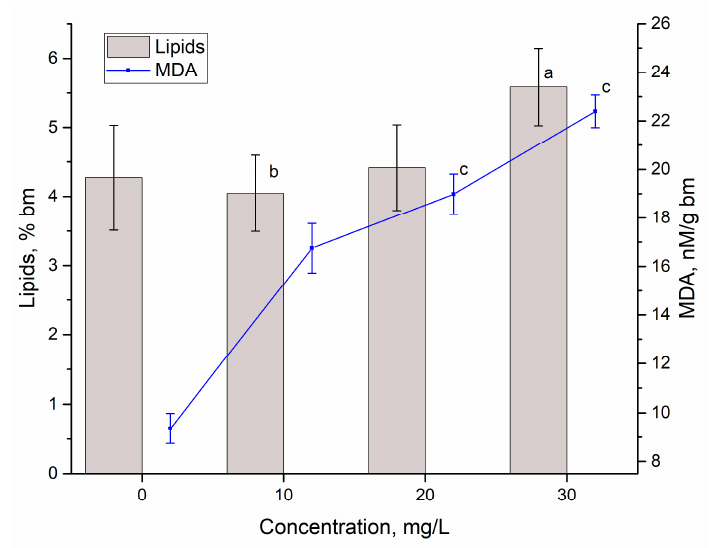
Figure 7. The content of lipids and malonic dialdehyde in the biomass of Arthrospira platensis exposed to Y(III) in a concentration of 10–30 mg/L (a— p < 0.005 for the difference between the sample and the control—lipids; b— p < 0.005 and c— p < 0.0005 for the difference between sample and control—MDA).